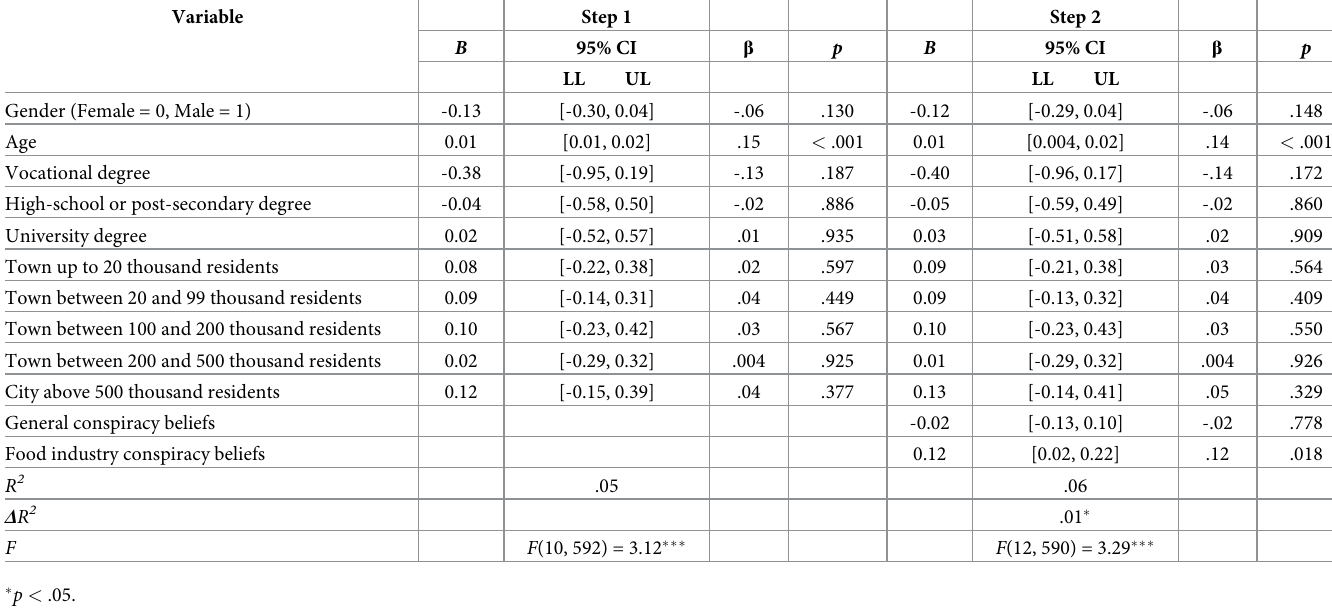
Table 2. Predictors of conscious food choices (Study